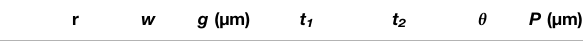
TABLE 1 | Geometric parameters of the unit cell.